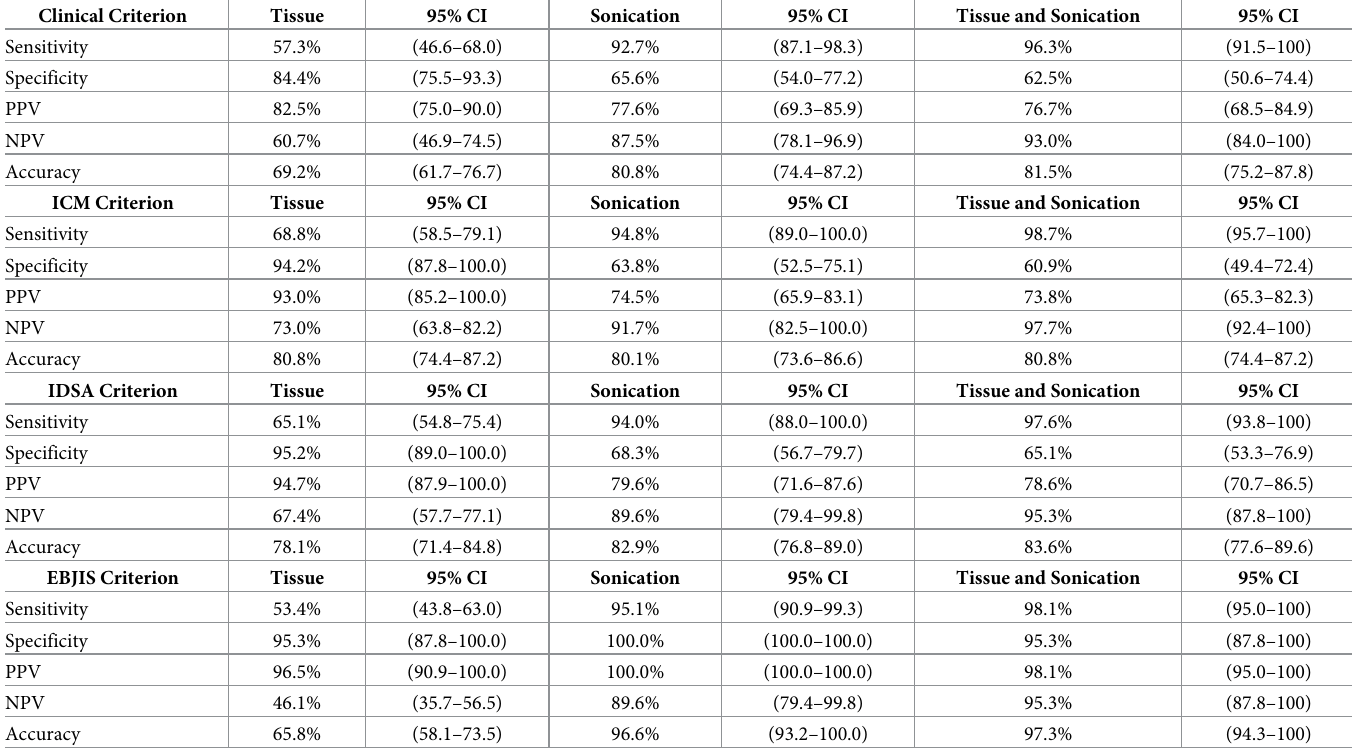
Table 3. Sensitivity, specificity, positive predictive value, negative predictive value and accuracy of tissue and sonication cultures isolated and of tissue and sonica- tion combined, according to proposed diagnostic criteria in 146 patients undergoing prosthetic joint